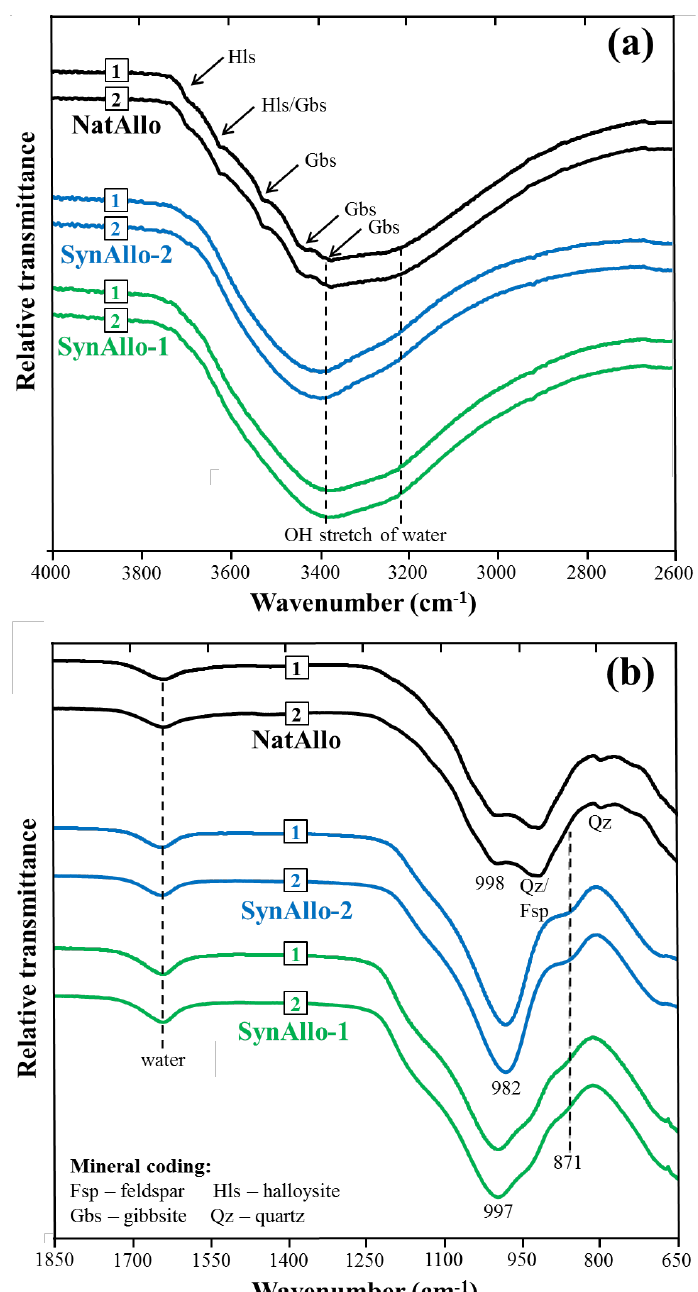
Figure 2. Attenuated total reflectance Fourier transform infrared (ATR-FTIR) spectra of NatAllo, SynAllo-1, and SynAllo-2 before the adsorption experiments (1) and with sorbed Zn 2+ ions (2). ( a ) Hydroxyl stretching region; ( b ) lattice vibration region.